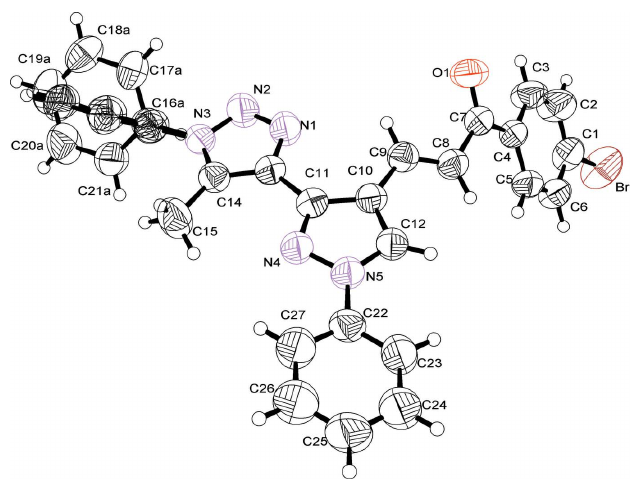
Figure 1 An ORTEP representation of the asymmetric unit showing 50% probability displacement ellipsoids.